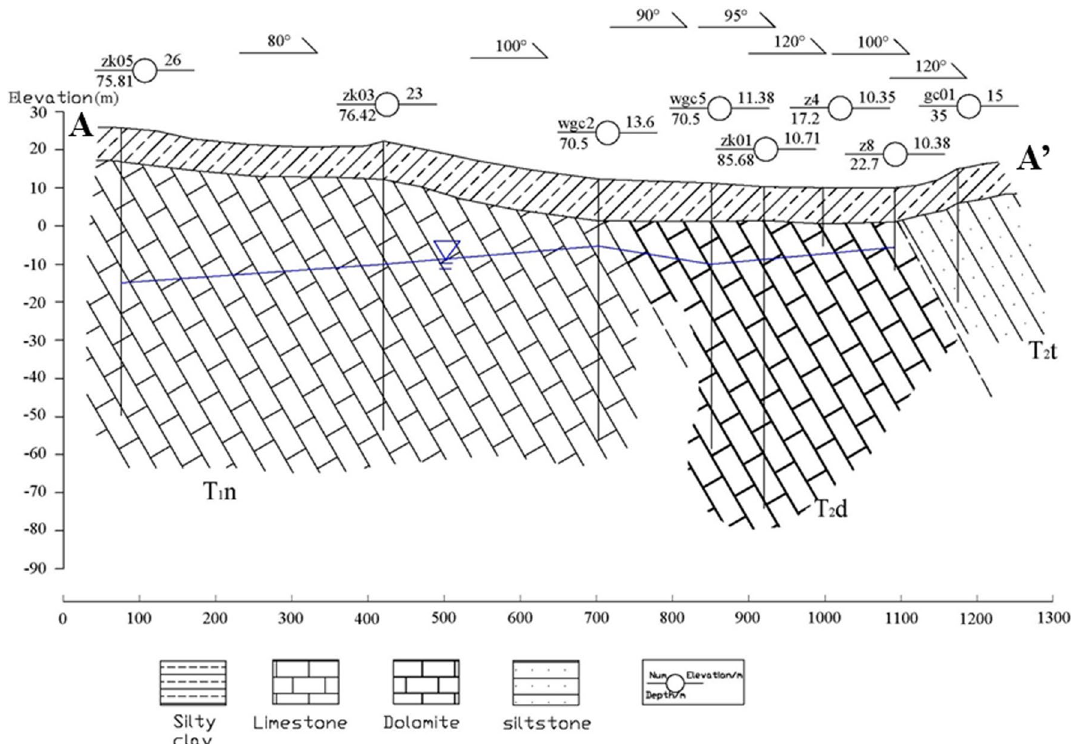
Fig. 4 Geological cross-section from west to east in the collapse area (water level gauged on November 17, 2014)